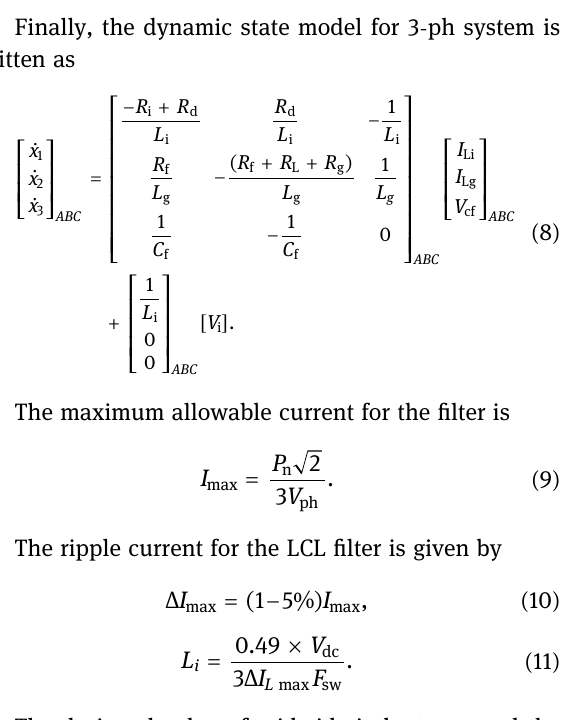
The designed value of grid - side inductance and the damping resistor of LCL fi lter is shown in equations ( 12 ) and ( 13 ) .